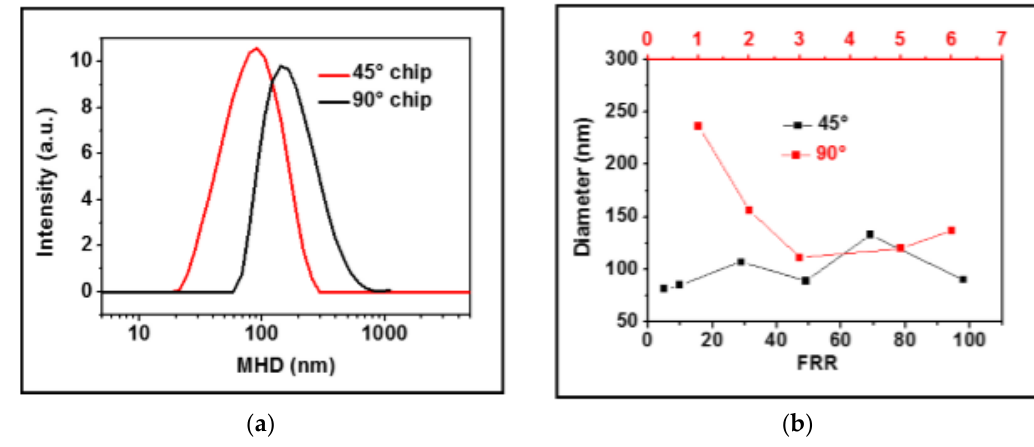
Figure 3. ( a ) Dynamic light scattering (DLS) spectra of liposome solutions produced inside 45° and 90° chips at FRR = 5 and at a lipid concentration of 0.9 mg/mL; ( b ) plot of the Z-average mean hydrodynamic diameter (MHD) versus the FRR of liposomes produced at a lipid concentration of 0.9 mg/mL inside 45° and 90° chips. The black x axis is related to FRRs used in the 45° chips and the red one (upper side of graph) to FRRs used in the 90° chips.